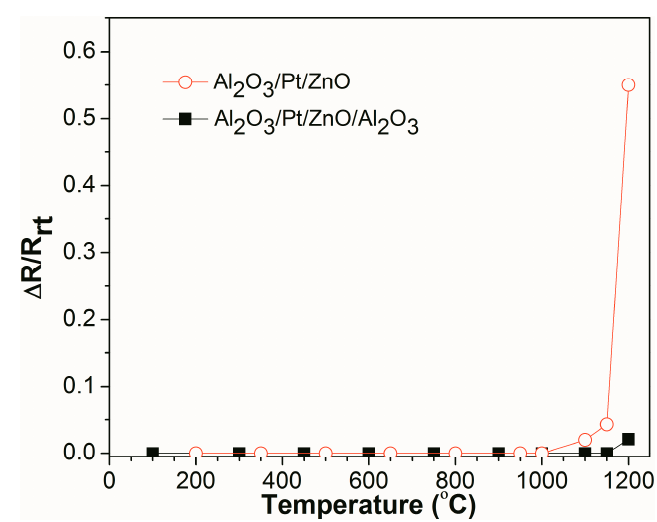
Figure 5. Relative resistance change for the Al 2 O 3 /Pt/ZnO/Al 2 O 3 /LGS and Al 2 O 3 /Pt/ZnO/LGS samples as a function of temperature from room temperature to 1200 °C.